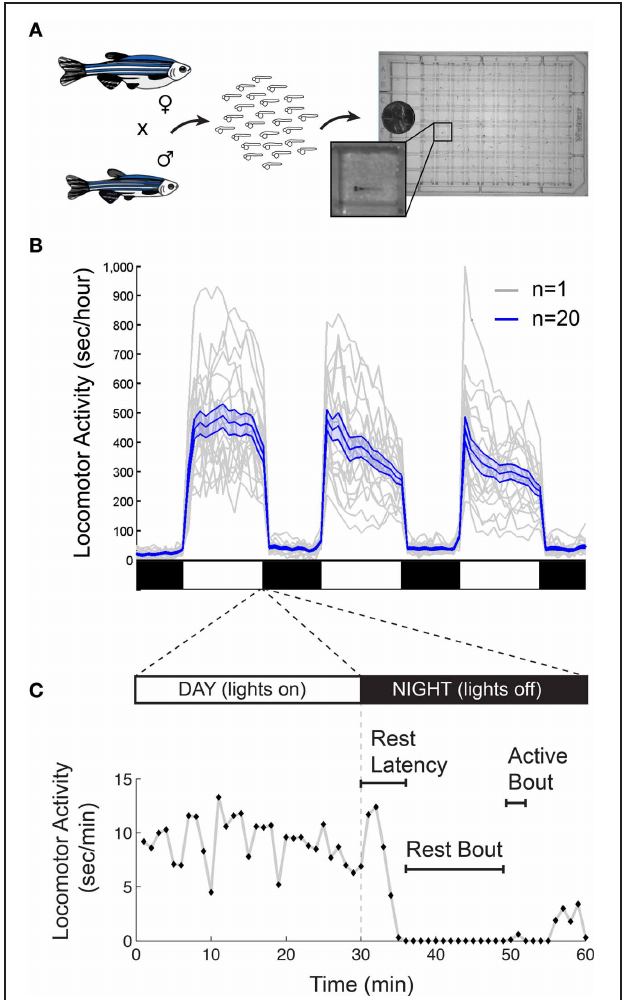
FIGURE 2 | Monitoring larval zebrafish sleep and wake behaviors. (A) Zebrafish larval locomotor activity assay. Individual zebrafish larva are placed in each well of a 96-well-plate on the 5th day of development. The plate is placed in a temperature-controlled chamber that is illuminated by white lights during the day and is continuously illuminated by infrared lights. The larvae are monitored by an infrared camera and the locomotor activity of each larva is recorded by a computer. (B) Representative locomotor activity data for each of 20 individual wild-type larvae (gray traces) and their mean locomotor activity (blue trace, ± standard error of the mean) is shown. Black and white bars indicate day and night, respectively. Larvae are more active during the day than at night, although there is considerable variability among individuals. (C) An example of typical larval zebrafish behavior at the end of the day is shown. A rest bout is defined as a period of at least 1min of inactivity, which is associated with an increase in arousal threshold (Prober et al., 2006). Rest latency indicates the time between lights off at night and initiation of the first rest bout. Figure modified from Prober et al.